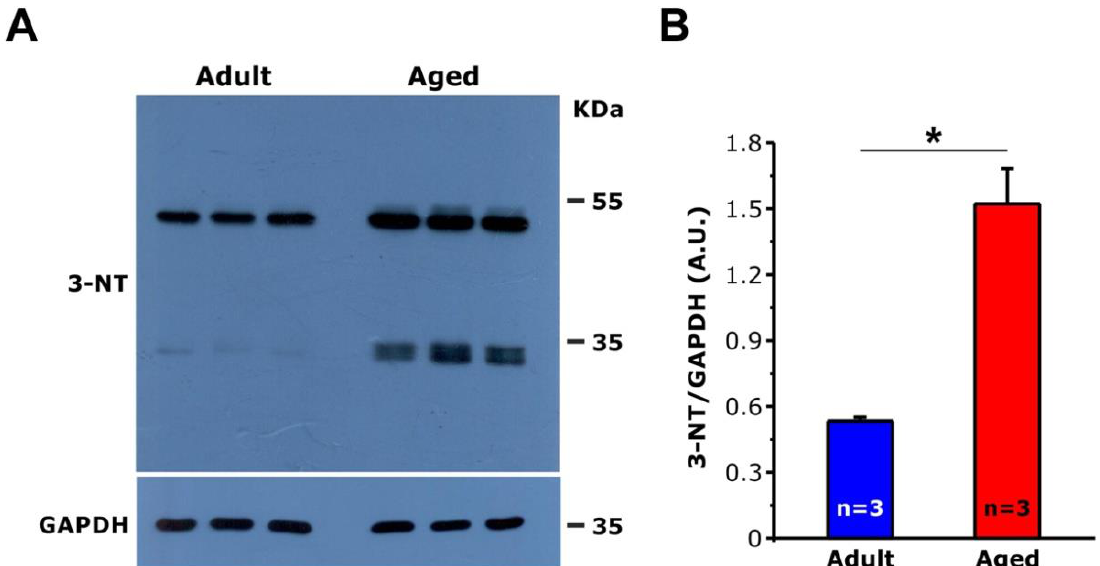
Figure 4. WB analysis of 3-nitrotyrosine (3-NT) for the assessment of oxidative stress. ( A ) Representative immunoblot showing 3-NT and GAPDH (used as loading control), in whole cardiac tissue homogenates from adult and aged mice. ( B ) Bar plots showing the quantitative analysis of the relative 3-NT expression levels by WB, calculated as the ratio between the average value obtained from the signal of the entire lane and GAPDH, for proper normalization. Data are shown as mean ± SEM (* p <0.05, unpaired two tailed t -test). n = number of mice. A.U., arbitrary units.